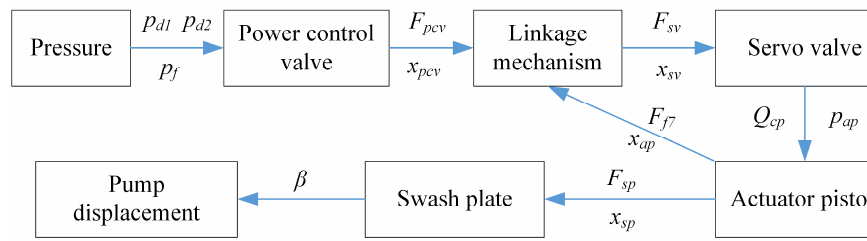
Figure 7. Flow chart of the power control.